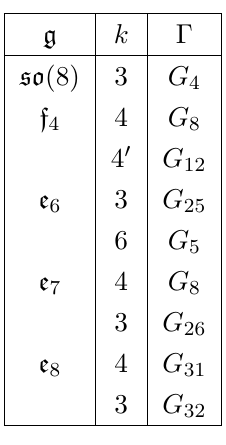
Table 14 . List of exotic 3d N = 6 theories that can be obtained via twisted compactification by N k R k of 4d N = 4 SYM with gauge algebra g . The exotic theories are characterized by their moduli spaces, which are of the form C 4 r / Γ , with Γ a complex reflection group. Note that the g = f 4 and e 8 cases do not involve non-invertible defects, and hence we do not discuss them in the main text, though we include the results in this table for